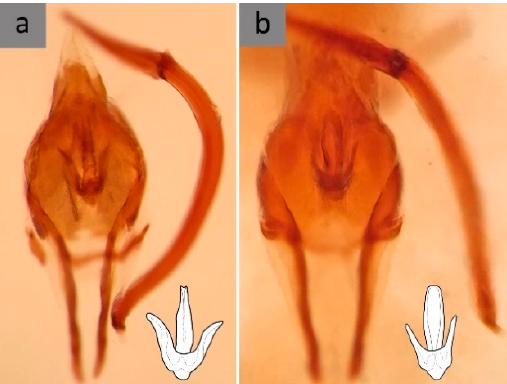
Figure 5. The male genital capsule of D. rufipennis ( a ) and D. murrayanae ( b ). An internal structure in the genital capsule, the endophallus, is seen through the median lobe (also inserts lower right corners). The endophallus is diagnostic for the two species when other means have been exhausted. Photos by J. Mercado. Endophallus line drawings adapted from Wood [7].